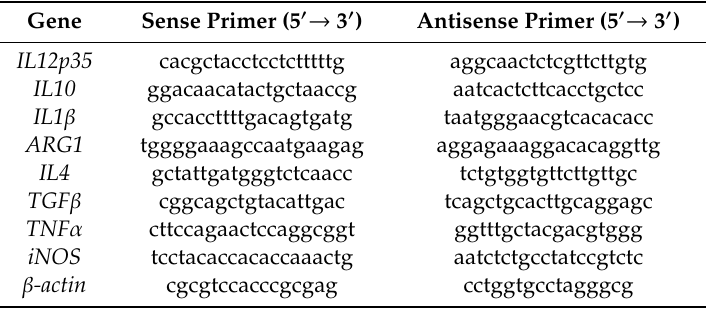
Table 2. Primer sequences used for the quantification of mouse